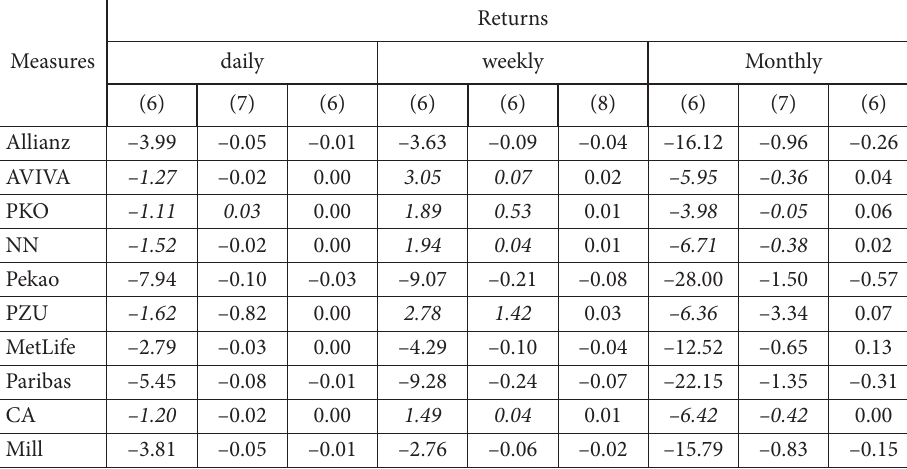
Table 14. Average values of Sharpe, Treynor and Jensen efficiency ratios evaluated for mutual funds for period c (source: own calculations)